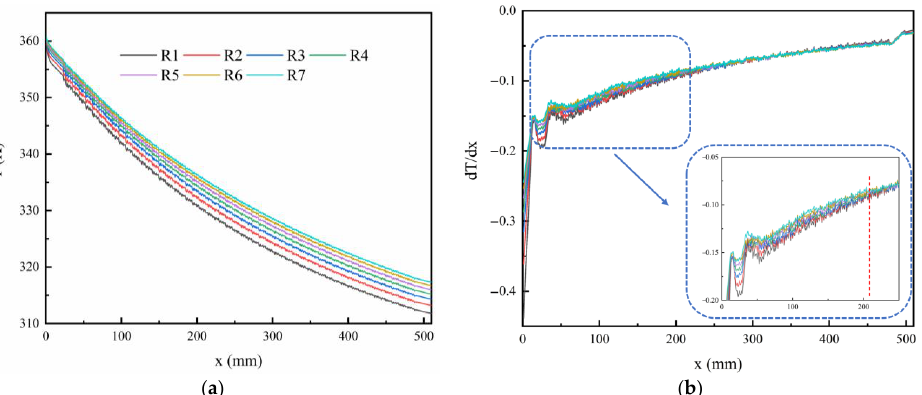
Figure 14. Mean static temperature ( a ) and its partial gradient in the stream-wise component ( b ) for different Reynolds numbers.